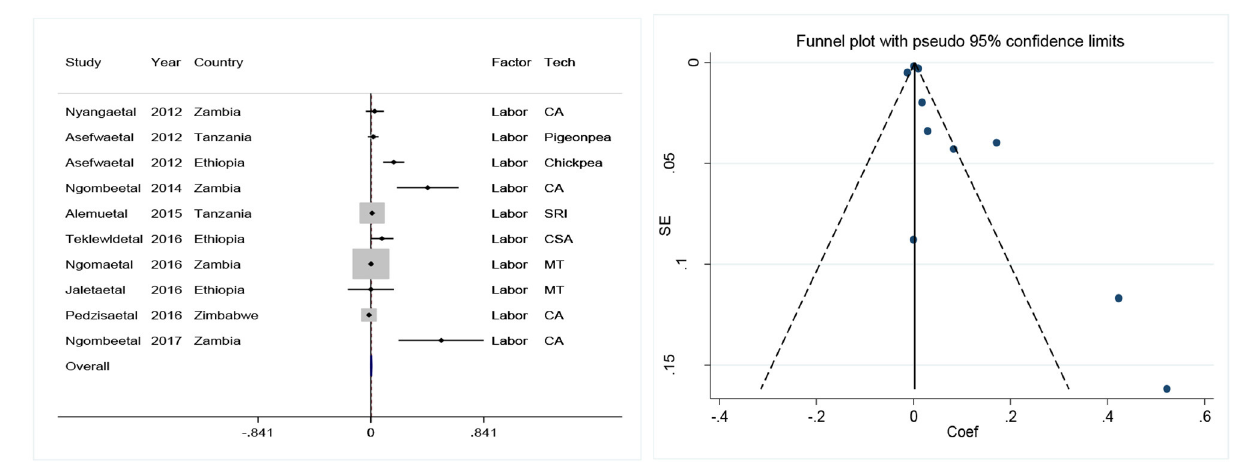
FIGURE 4 | The effects of labor availability on the adoption of various CSA practices in parts of Eastern and Southern Africa. Source: Computed from Asfaw et al. (2012), Nyanga (2012), Teklewold et al. (2013), Ngombe et al. (2014), Alem et al. (2015), Pedzisa et al. (2015), Ngoma et al. (2016), and Ng’ombe et al. (2017). The horizontal lines in the forest plots are the confidence intervals (CI) and the gray areas are study weights generated in the meta function. CIs that cross the zero line indicate statistical insignificance, while those on the left (right) show statistically significant negative (positive)